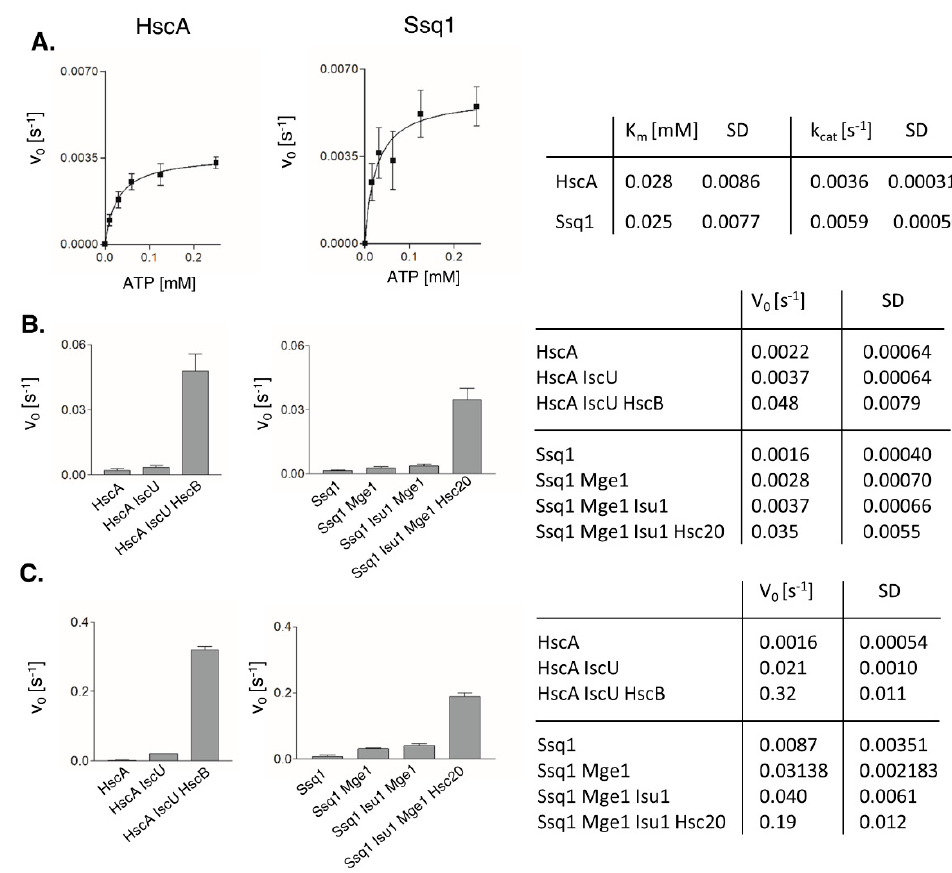
Figure 2. ATPase activities of HscA and Ssq1. ( A ) A ffi nity of HscA and Ssq1 for ATP. Reaction mixtures contained 1 µ M HscA or 2.5 µ M Ssq1 and Mge1. ATPase rates were measured at various ATP concentrations using an enzyme-coupled assay. Curves are the best fits of the data to the Michaelis–Menten equation. Error bars represent SD for three independent measurements. ( B , C ) Stimulation of HscA and Ssq1 ATPase activities in the presence of protein substrates and JDP cochaperones. Average ATPase rates for three independent measurements with error bars as SD are shown at left, and in table form at right. ( B ) The reaction mixtures contained 120 µ M ATP, 0.5 µ M HscA, 2 µ M HscB, 10 µ M IscU or 0.5 µ M Ssq1, 2 µ M Hsc20, 10 µ M Isu1 and 0.5 µ M Mge1. The release of radioactive inorganic phosphate from [ γ − 33 P] ATP was measured. ( C ) The reaction mixtures